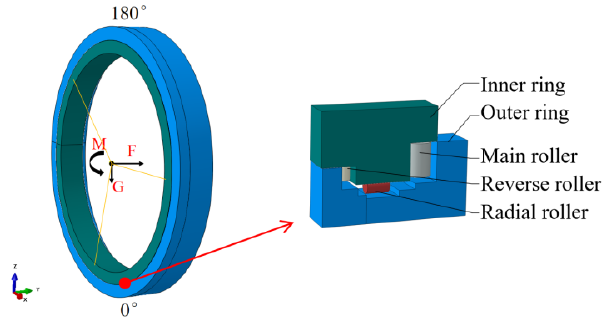
Figure 1. Structure diagram of TBM main bearing.